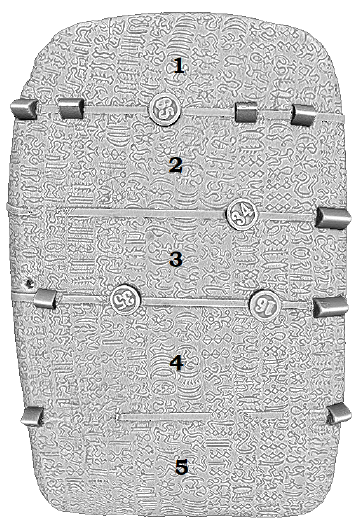
Figure 4: The markers on the 3D model and the five sub-areas